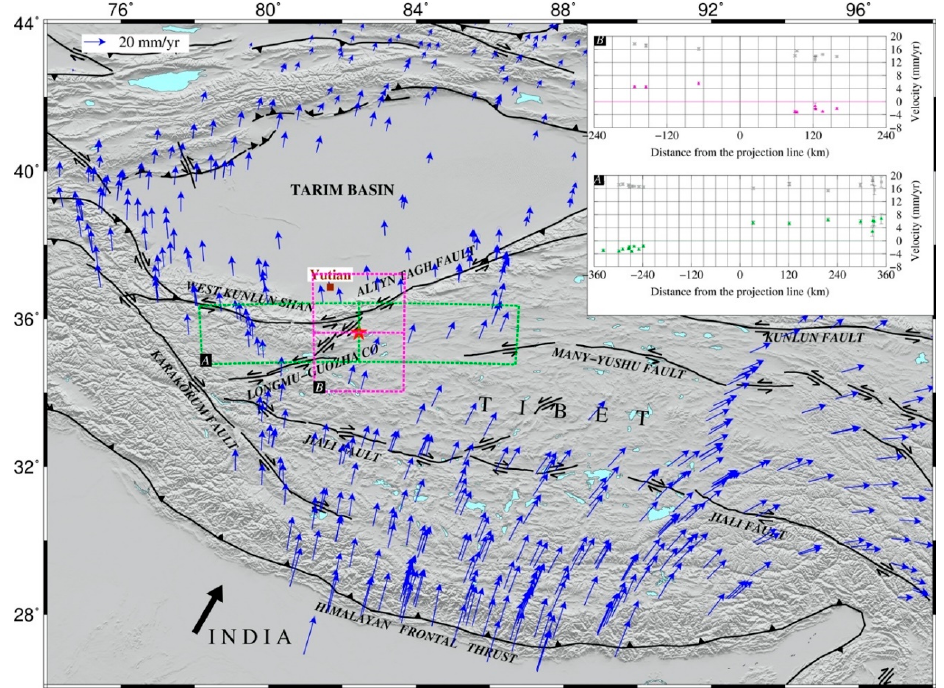
Figure 11. GPS velocities in Tibet (after [49]). Blue arrows represent horizontal GPS-derived interseismic velocities with respect to stable Eurasia. Green and pink rectangle zones show GPS profiles A and B, which were selected to analyze strike-slip and extension throughout the northwestern corner of Tibet. The insert map shows E–W and N–S motion components for profiles A and B. In profile A, green triangular points and gray square points indicate E–W and N–S motion components. In profile B, pink triangular points and gray square points indicate N–S and E–W motion components.